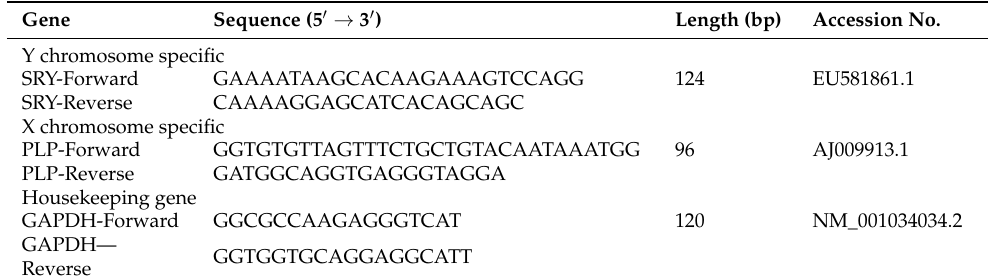
Table 1. Specific primers used to amplify bovine SRY, PLP and